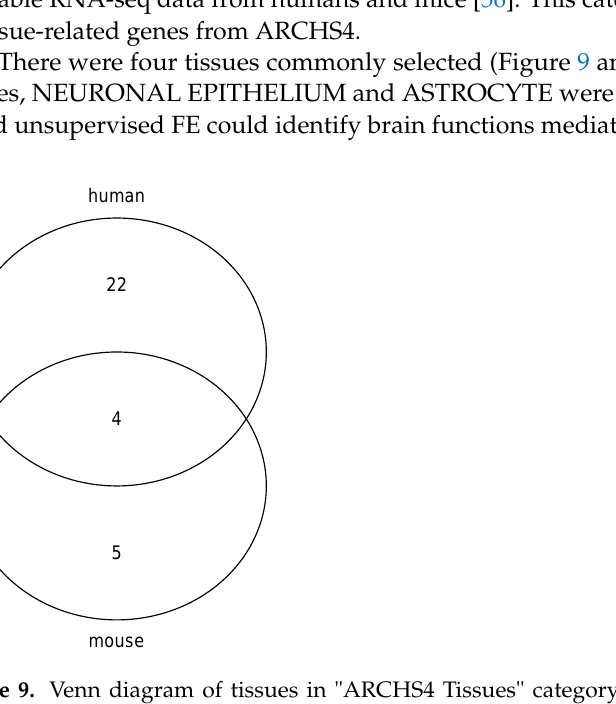
Figure 9. Venn diagram of tissues in "ARCHS4 Tissues" category, selected by uploading genes selected by TD-based unsupervised FE to